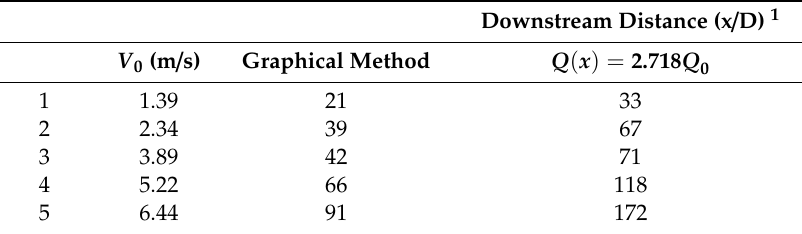
Table 2. Downstream distance at which the jet is fully